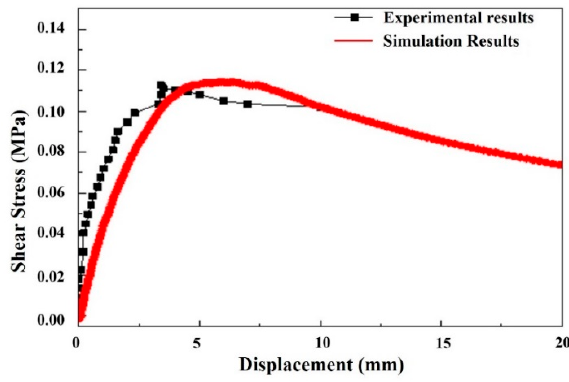
Figure 4. Comparison of simulation and experiment results.